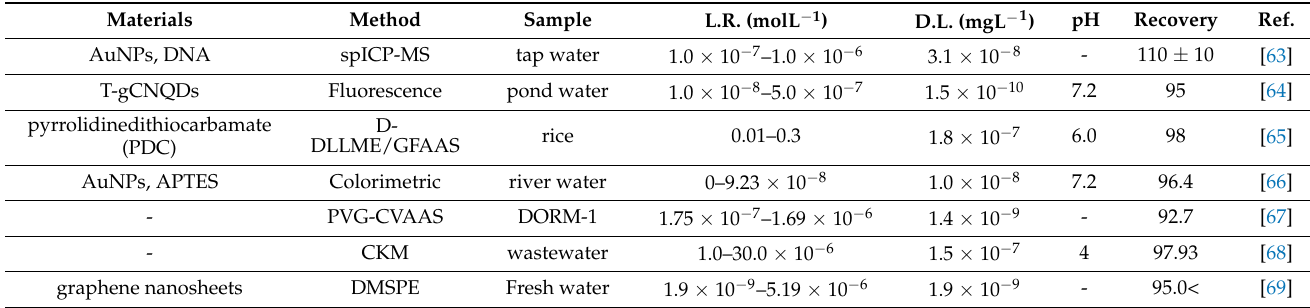
Table 6. Comparisons of analytical results for the detection of Hg 2+ by using other